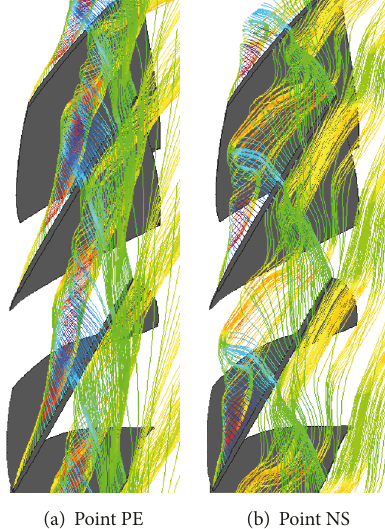
Figure 3: Streaklines that depict the TLF structures ([12]). Figure reproduced from LIN et al. (2010).